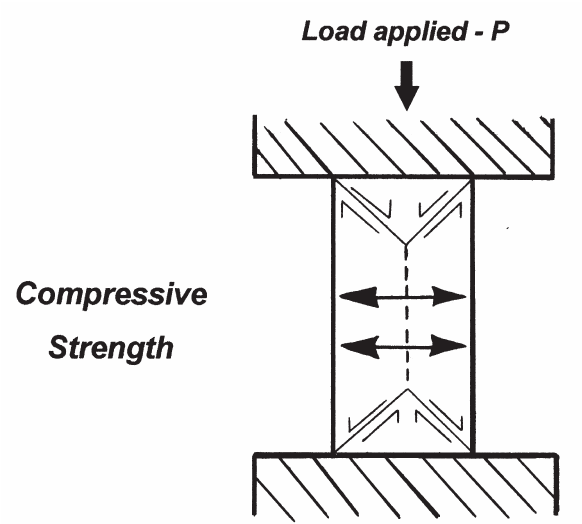
FIGURE 2- Schematic illustration of Compressive Strength adapted from Darvell 7 , 2000. The stress and causes of failure in a cylindrical specimen loaded axially are no different from those in the diametral case except that the pattern is radially symetrical 7